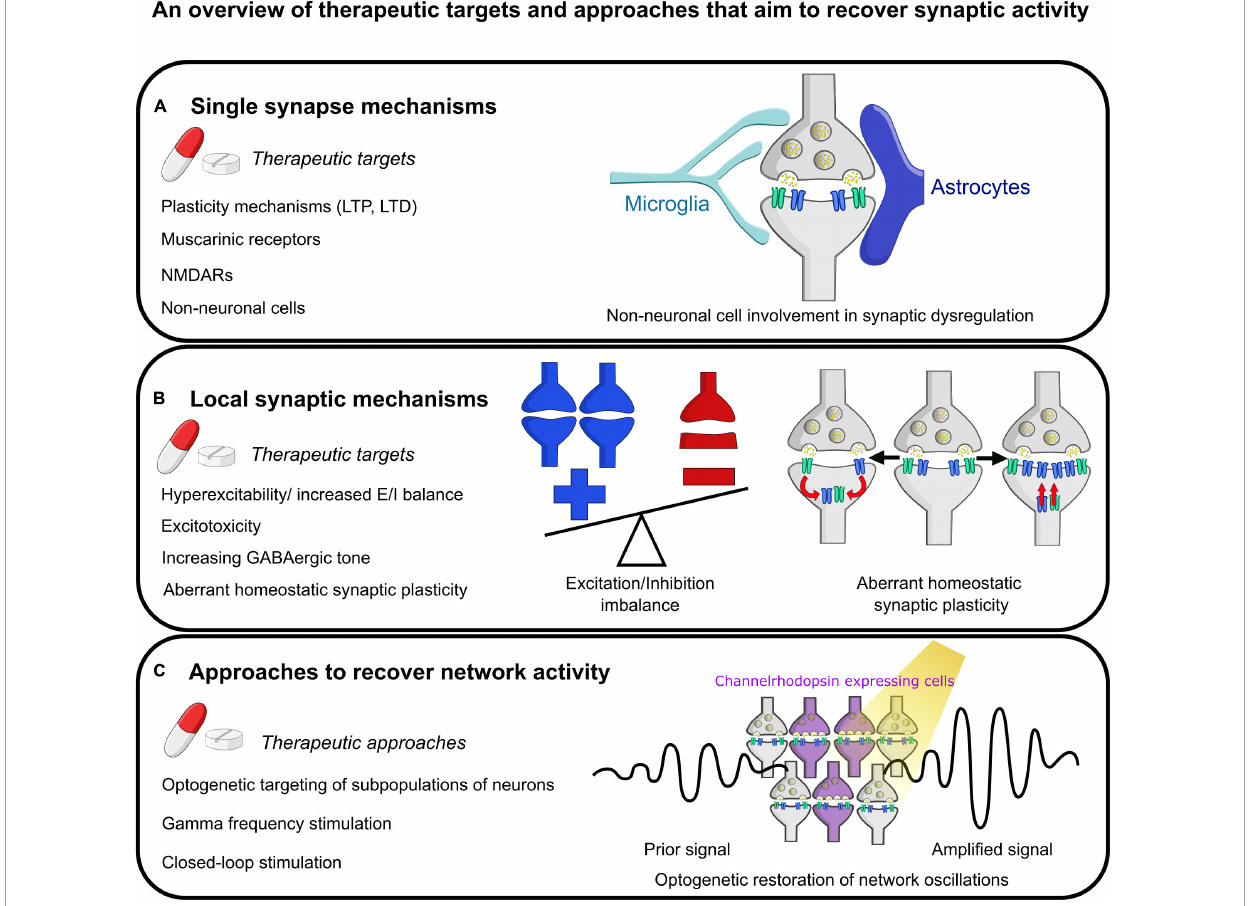
FIGURE3 Summary of some future therapeutic targets aimed at restoring normal synaptic physiology. (A) Mechanisms targeting individual synapses. This includes targeting short- and long- term plasticity (STP and LTP, respectively) at the synapse, modulation of muscarinic receptor and NMDA receptor activity, and targeting aberrant activity of non-neuronal cells such as microglia and astrocytes on synapses. (B) Therapeutic mechanisms at the local synaptic level. This includes reducing hyperexcitability or restoring E/I imbalance, preventing excitotoxicity, increasing GABAergic tone, and evaluating the effect of aberrant homeostatic synaptic plasticity. The example images show an imbalance of excitation and inhibition with more excitation as has been described in the literature. Next shows one mechanism of homeostatic synaptic plasticity, synaptic scaling, with either abnormal increases or decreases in synaptic strength by altering the number of receptors present at the post-synaptic density. (C) Therapeutic mechanisms that could be utilized to rescue network activity including optogenetic modulation of the activity of subpopulations of neurons (as shown in the pictogram), stimulation of neurons at gamma-band frequency, and more sophisticated closed-loop network modulation to attempt to recover activity to normal physiological set points following